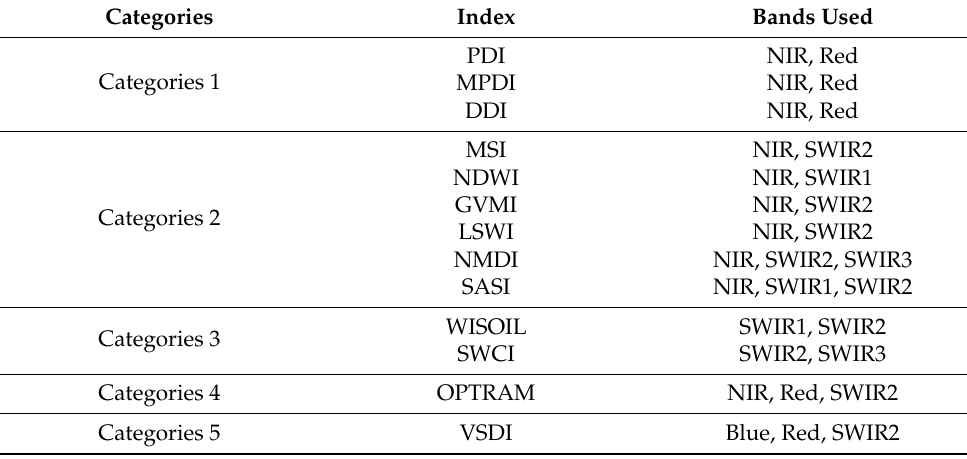
Table 5. Classification of the typical optical SM